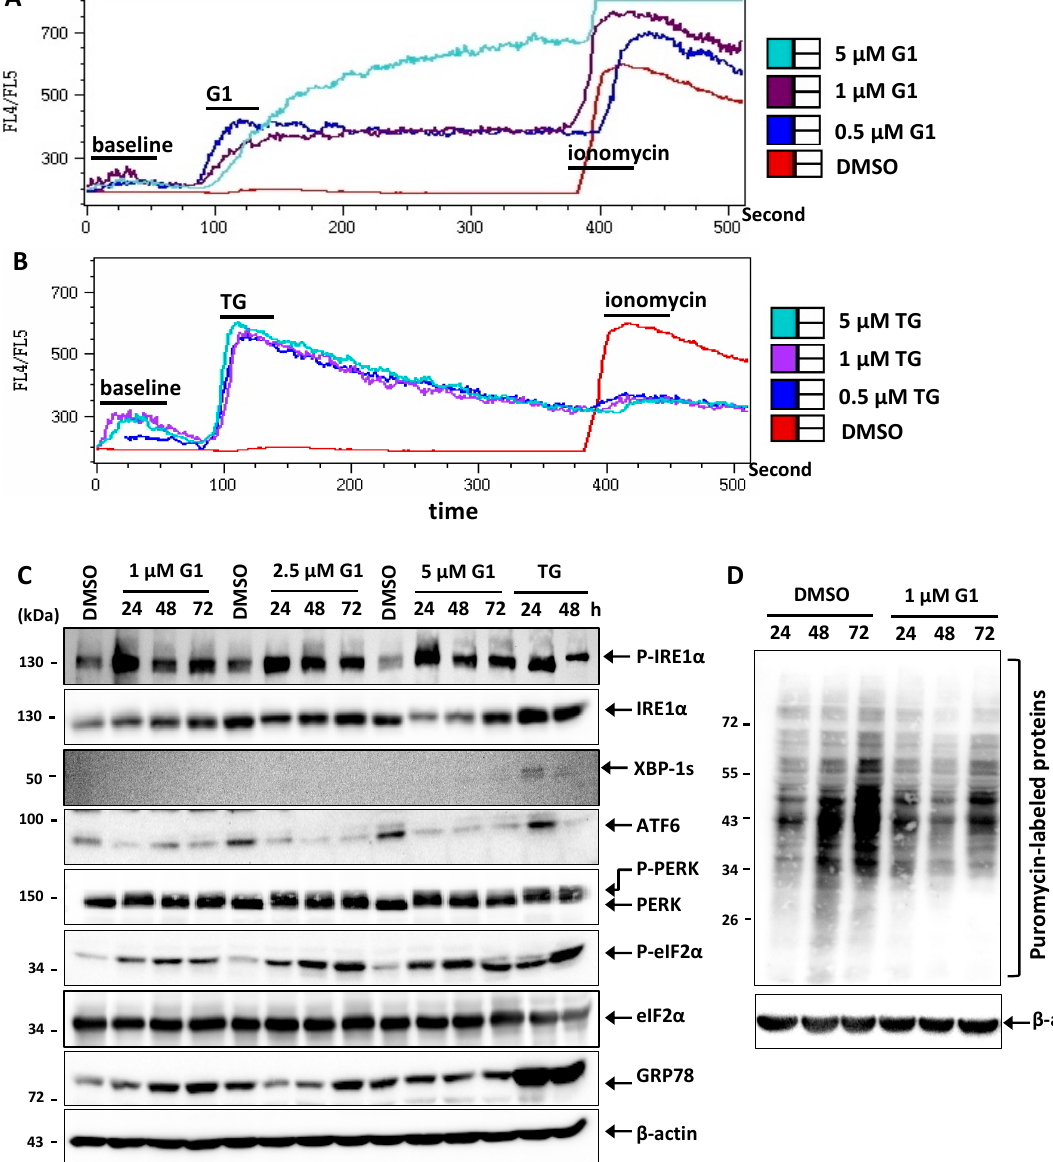
Figure 2. G1 and TG induced Ca 2+ efflux and activated the UPR in MCF-7 cells. ( A , B ) Intracellular Ca 2+ concentration was measured by flow cytometry in Indo-1-stained MCF-7 cells after stimulation with different concentrations of G1 or TG. To demonstrate successful loading with the dye, we induced maximal Ca 2+ release by adding calcium ionophore ionomycin (10 mg/mL) at the end of a measurement. ( C ) MCF-7 cells were treated with 1, 2.5 and 5 µM G1 for 24, 48 and 72 h, or with 1 µM TG for 24 and 48 h. ( D ) MCF-7 cells were treated with 1 µM G1 for 24, 48 and 72 h. A total of 15 min before the end of a treatment time, 10 µg/mL puromycin was added. Total protein lysates were subjected to Western blotting using appropriate antibodies as indicated.